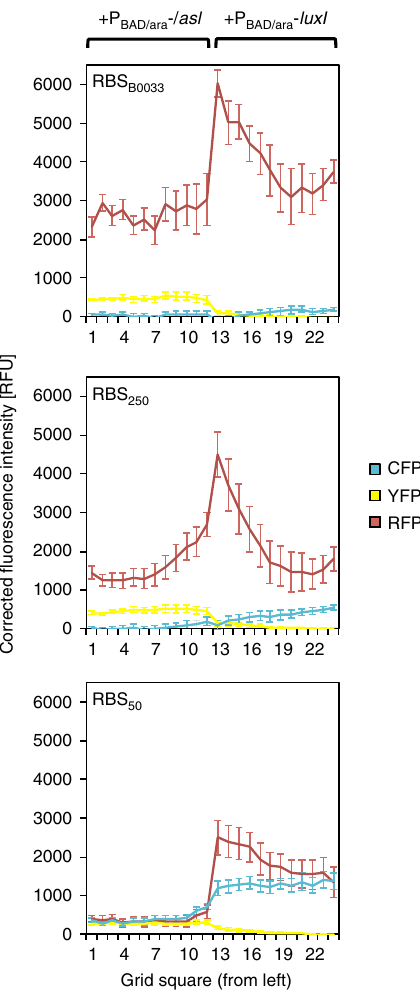
Fig. 6 Programmed emergence of an RFP-expressing domain across bacterial populations. TOP10 E . coli were co-transformed by the RFP reporter plasmid p4g3R, a bicistronic controller plasmid pCRB DRT7VTPLux*(500/250/50), and a sender plasmid pSB1C3 I0500 (LuxI/ LasI) encoding either luxI or lasI under control of the arabinose-inducible P BAD/araC promoter. Adjacent populations of the different triple- transformed cell types were incubated on membranes placed on minimal nutrient agar which has or has not been supplemented with 25 mM arabinose. Fluorescence intensity of each quadrant at t = 3000 min (time relative to start of incubation), corrected for background signal present in the absence of arabinose, is plotted against position (genotype boundary between quadrants 12 and 13). Error bars represent the s.d. of average values between the 12 equidistant quadrants on each